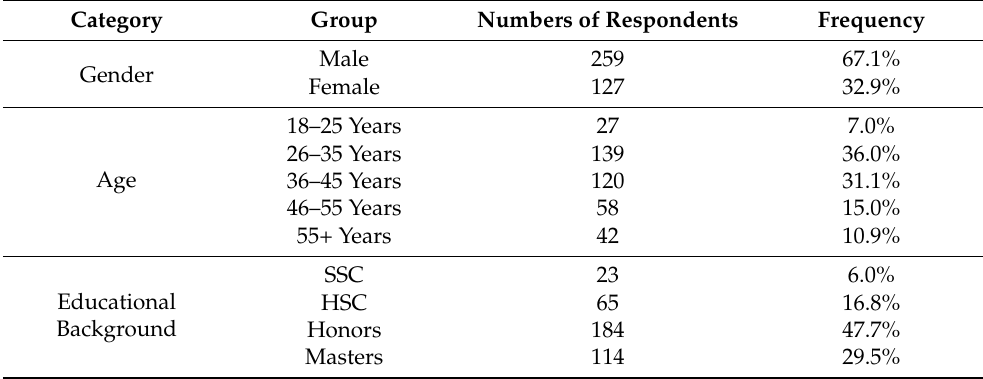
Table 1. Demographic